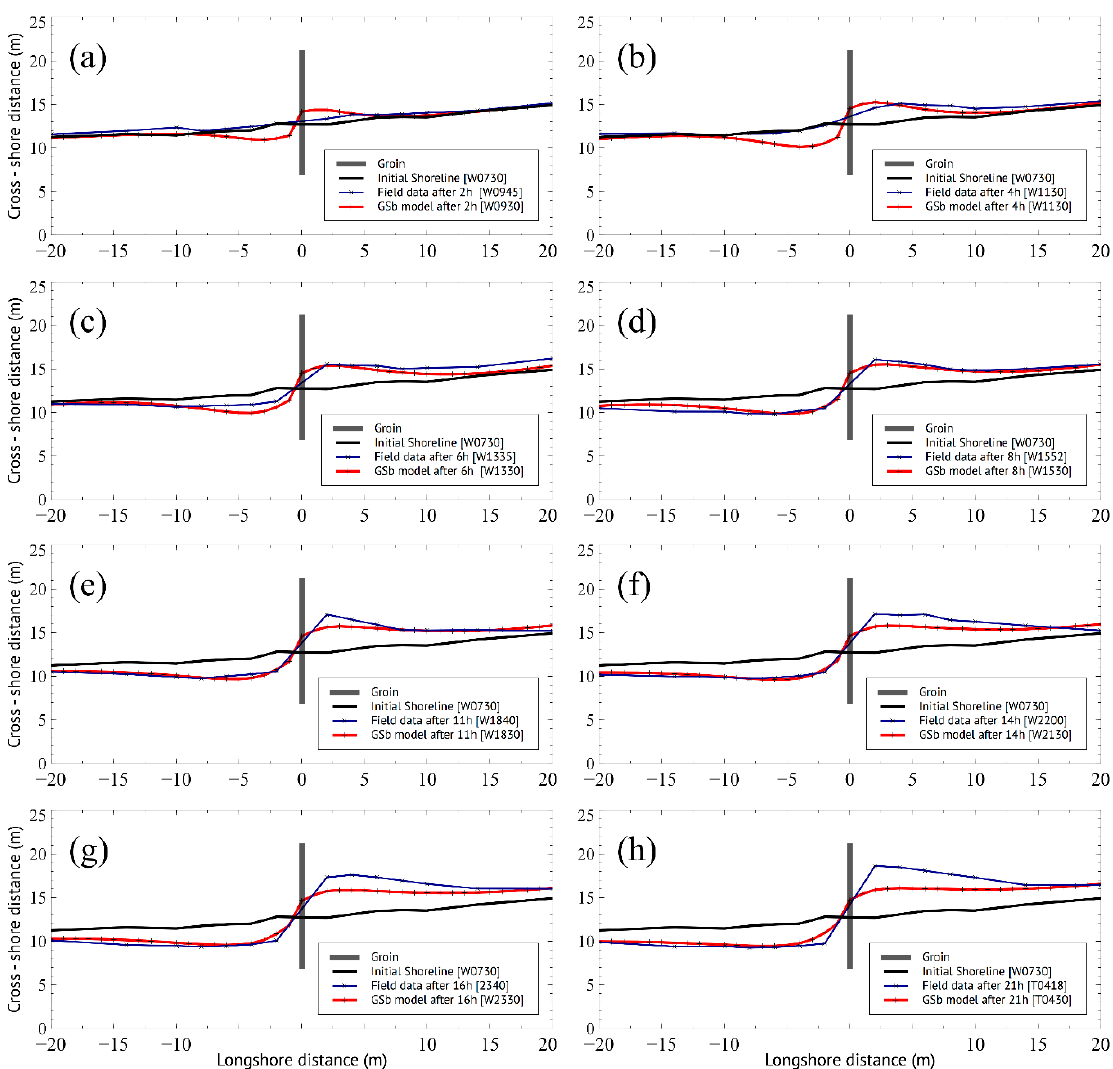
Figure 12. Measured and calculated shoreline position ( a ) 2 h, ( b ) 4 h, ( c ) 6 h, ( d ) 8 h, ( e ) 11 h, ( f ) 14 h, ( g ) 16 h and ( h ) 21 h after the structure deployment. Information on the brackets indicates the corresponding weekday (W = Wednesday, T = Thursday) and local time of field data and GSb simulation.